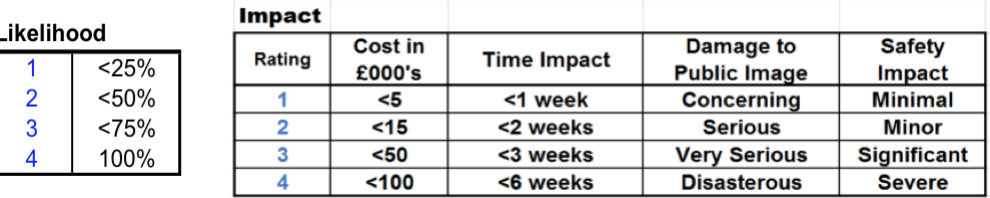
Figure 5. Matrices to assign a quantitative value to likelihood and